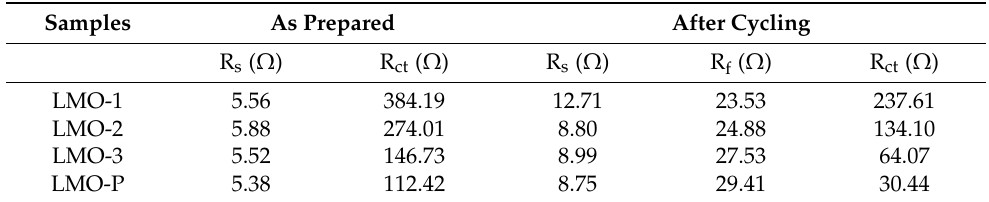
Figure 9. Electrochemical impedance spectra (EIS) of the various samples before ( a ) and after 15 cycles ( b , c ). Table 3. Electrochemical parameters for the alternating current EIS results, calculated using Z-view software.